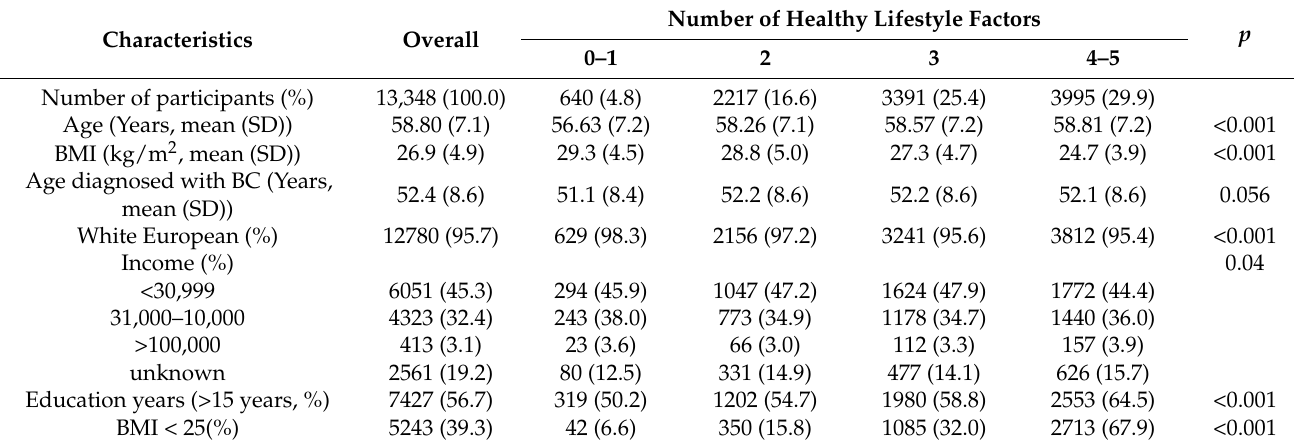
Table 1. Baseline characteristics of the study participants according to number of healthy lifestyle